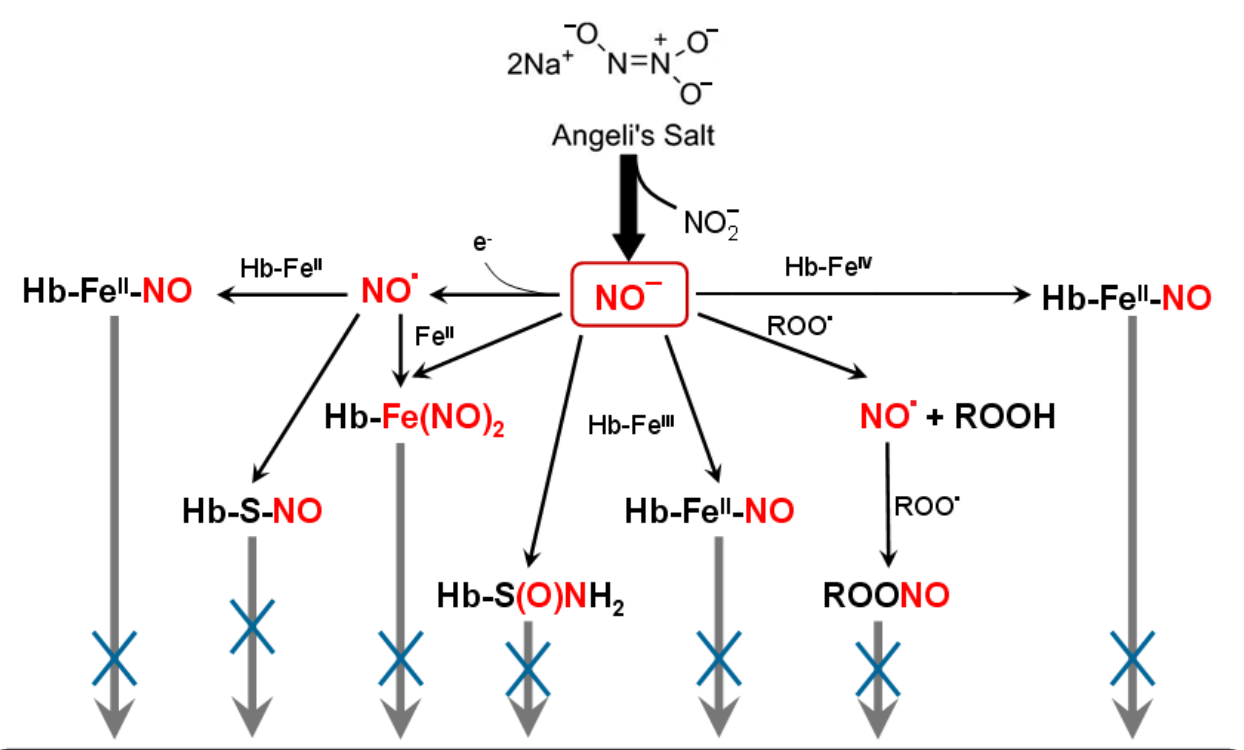
Figure 11. Schematic representation of antioxidant and antiglycation effect of HNO donor, Angeli’s salt, on hemoglobin.